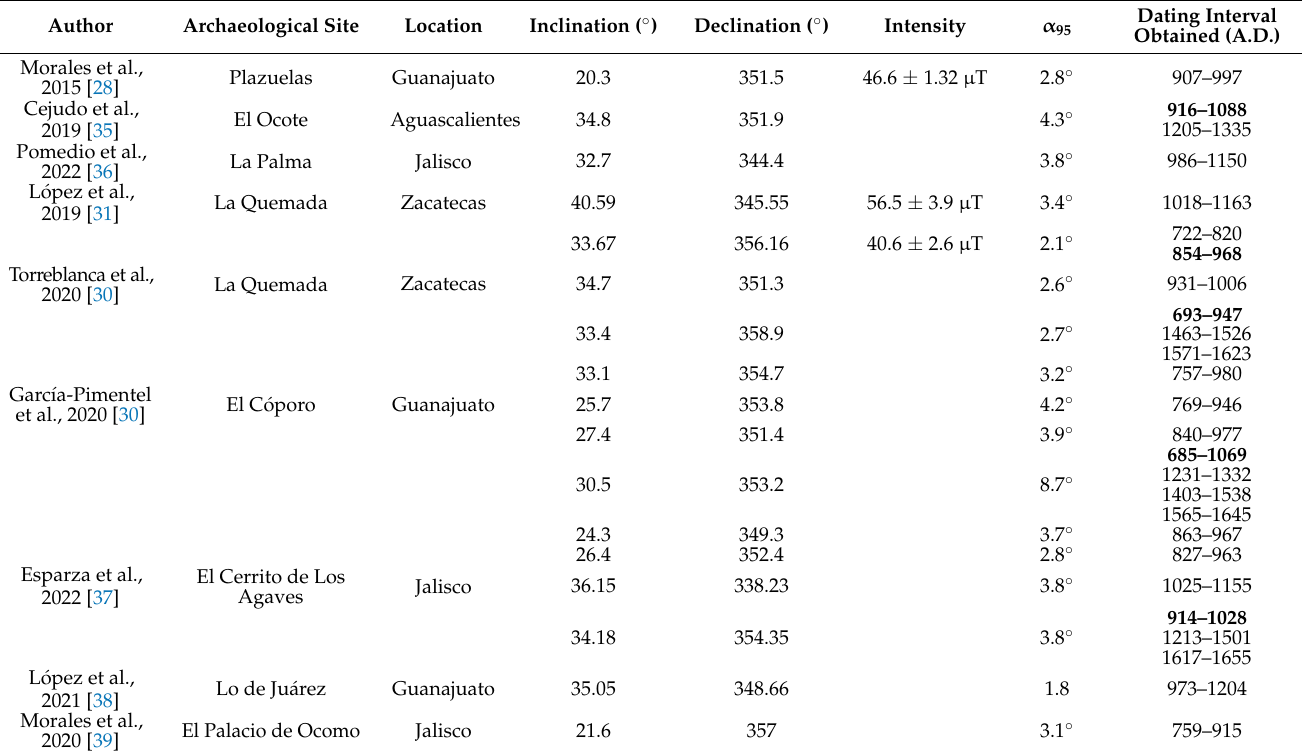
Table 1. Available archaeomagnetic data for the archaeological sites belonging to the northern frontier of Mesoamerica indicating their location, possible age intervals and the geomagnetic model